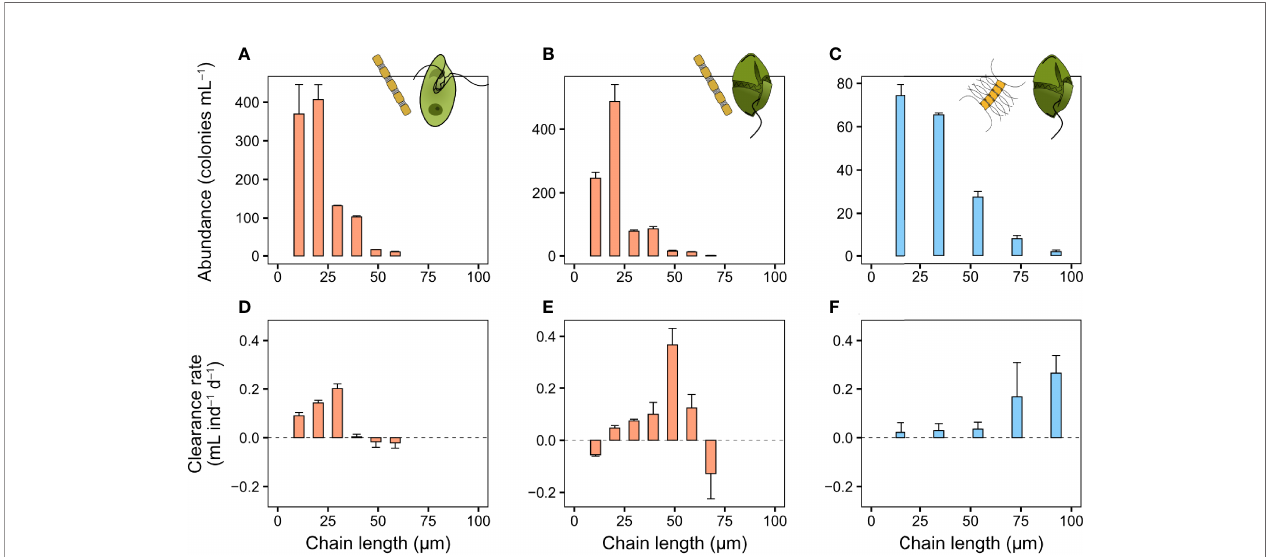
FIGURE 5 | Heterotrophic dino fl agellate clearance rate (mL ind − 1 d − 1 ) and colony size distribution of diatom chains in the bottle incubations. (A, D) O. marina feeding on S. marinoi and G. dominans feeding on (B, E) S. marinoi and (C, F) C. af fi nis. Sizes larger than the largest shown here (equivalent to six, seven, and fi ve cells chain in the three columns from left to right, respectively) were pooled into one group due to low abundance of these sizes. Values are means and error bars show standard error (n =